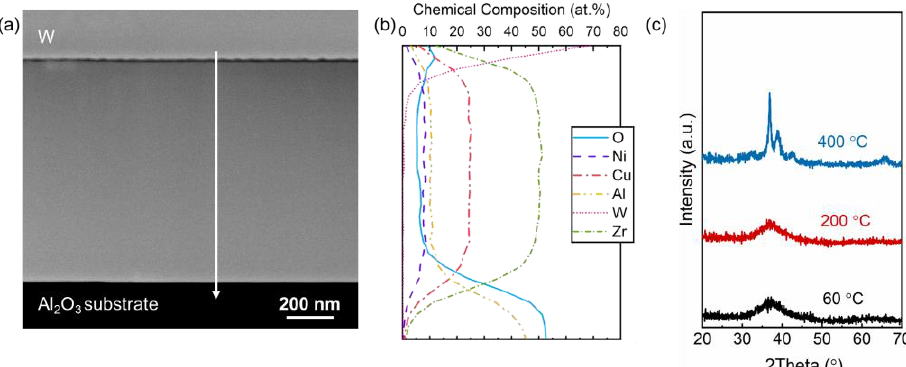
Figure 2. ( a ) High-angle annular dark field scanning transmission electron microscopy (HAADF STEM) image of the ZrCuAlNi film deposited at 200 °C with direct current magnetron sputtering (DCMS) and ( b ) energy-dispersive X-ray spectroscopy (EDX) line scan measured along the arrow represented in ( a ). ( c ) X-ray diffraction of thin-film metallic glasses (TFMGs) deposited at 60, 200 and 400 °C.